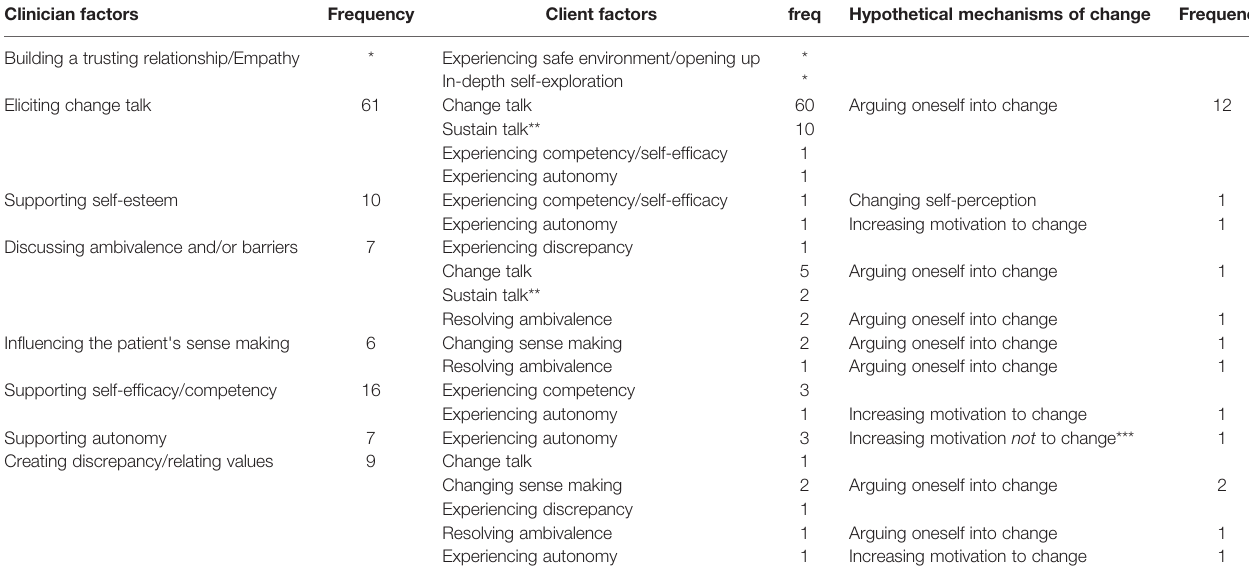
TABLE 5 | Clinician factors, client factors, mechanisms of